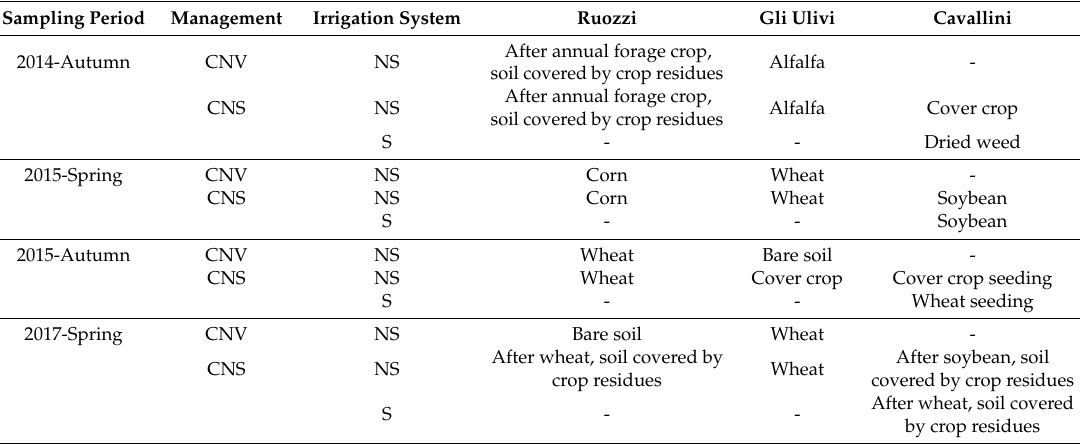
Table 1. Crop types for each sampling period in the three farms: Ruozzi, Gli Ulivi, and